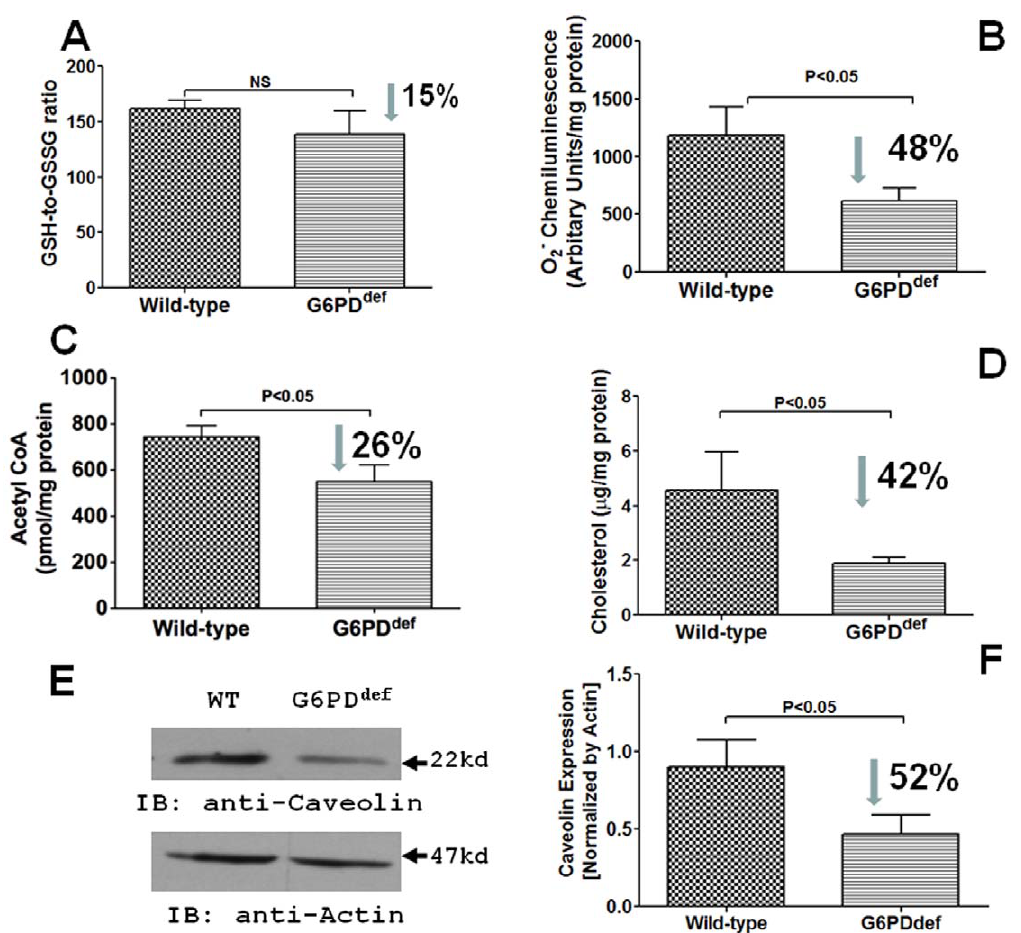
Figure 5. Redox, acetyl CoA and cholesterol levels in G6PD deficient mice hearts. Metabolites produced from NADPH-dependent reaction were estimated in wild-type and G6PD deficient mice hearts. A and B: G6PD deficiency decreased reduced glutathione-to-oxidized glutathione (GSH-to- GSSG; A) ratios determined by colorimetric assay and superoxide (O2 2 ; B) estimated by lucigenin (5 m M) chemiluminescence method. Concurrently, G6PD deficiency lowered NADPH-dependent free fatty acid b -oxidation, which produces acetyl CoA (C), cholesterol synthesis (D), and caveolin (E–F) in the hearts as well.